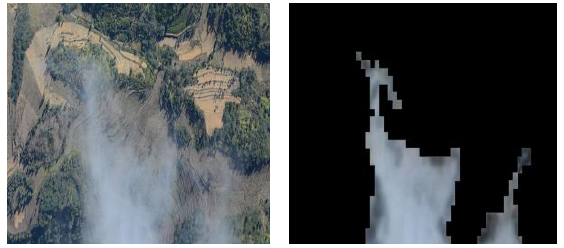
Figure 3. Image comparison using linear model